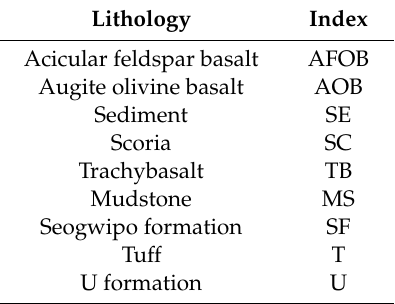
Table 4. Indices of